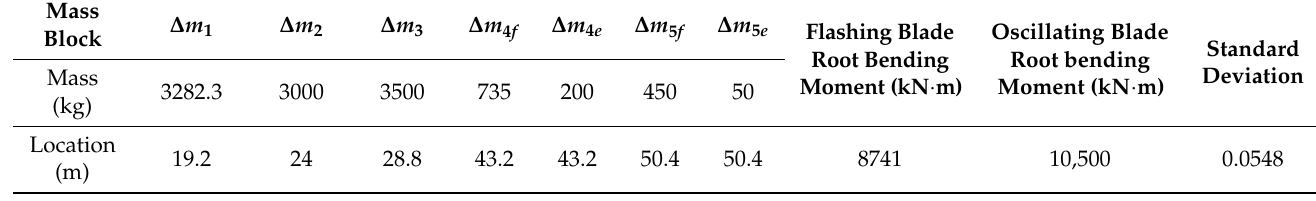
Table 2. Convergence results of the case study.